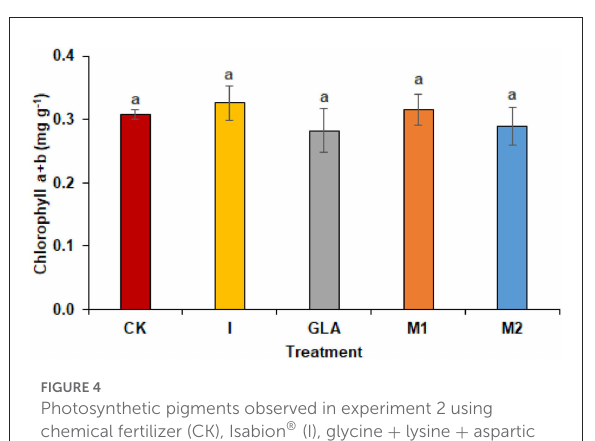
FIGURE4 Photosynthetic pigments observed in experiment 2 using chemical fertilizer (CK), Isabion ® (I), glycine + lysine + aspartic acid (GLA), moringa leaf extract + GLA (M1), 25% NPK + M1 (M2). The values mentioned herein are indicated as mean ± S.D and the lowercase letters indicate the significant difference among the means.